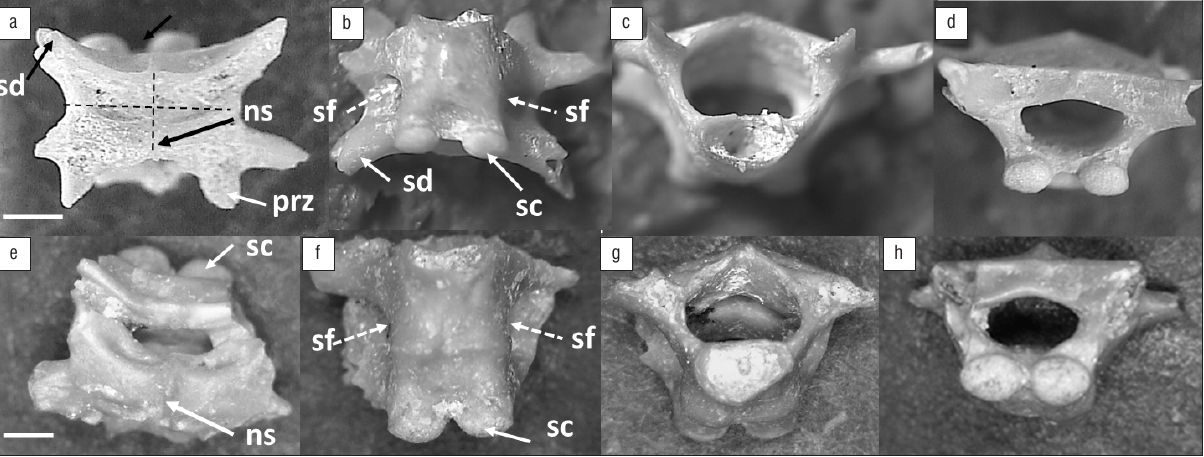
Figure 2: (Top) Ptychadena indet. sp. 1 (Family: Ptychadenidae) from Langebaanweg, requisition number SAM-PQL-70839, in (a) dorsal, (b) ventral, (c) anterior and (d) posterior views. (Bottom) Ptychadena indet. sp. 2 (Family: Ptychadenidae) from Langebaanweg, requisition number SAM- PQL-71524, in (e) dorsal, (f) ventral, (g) anterior and (h) posterior